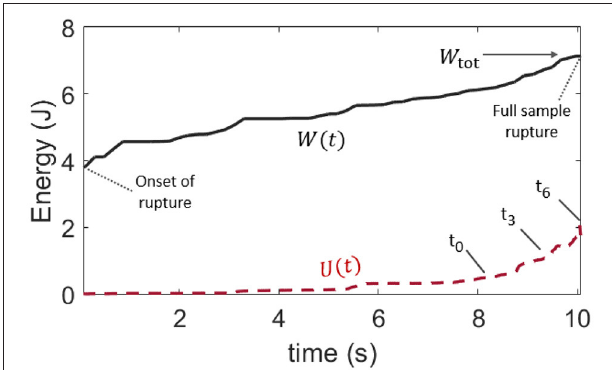
FIGURE 5 | Comparison of the time evolution of the provided mechanical load W , as per Figure 4 , and that of the rise in internal (thermal) energy U in the skin sample, as per Equation (4). This plot is for skin specimen V. Labels t 0 to t 6 refer to the frames of Figure 3 . The mean observable thermal efficiency, U / W tot at the end of the rupture, is here about which is the ratio φ =